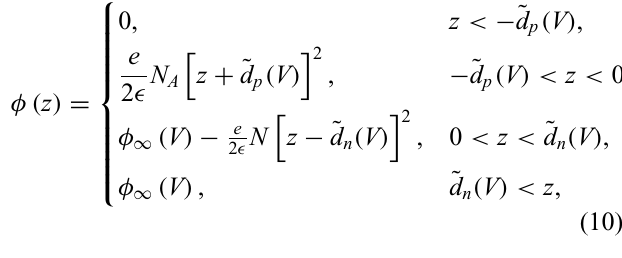
= (cid:6) − (cid:6) v , g c